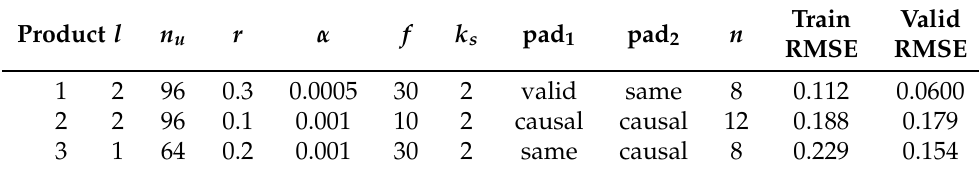
Table A2. Results of the grid search on class B (CNN + LSTM) univariate models.